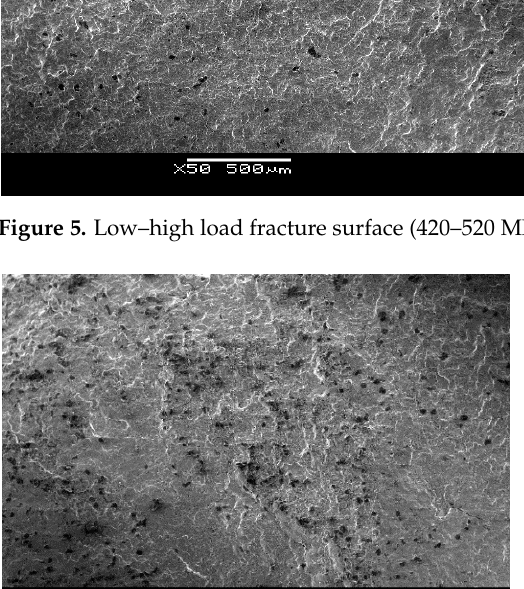
Figure 6. High–low load fracture surface (520–420 MPa, n 1 /N 1 = 0.25). Binarize the middle part of Figures 5 and 6 to obtain Figures 7 and 8.